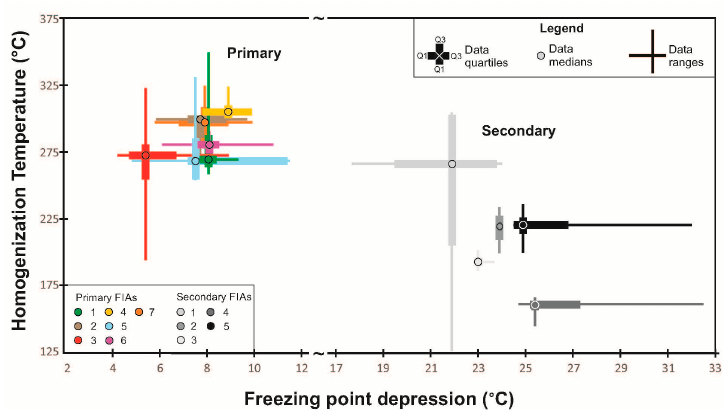
Figure 9. Two-dimensional box and whisker plot for two-phase liquid-rich fluid primary and secondary fluid inclusions from Poona emerald. Total homogenisation and ice melting temperatures are shown on the ordinate and abscissa axes respectively. The number of fluid inclusions measured for the primary assemblages are 4, 4, 5, 4, 5, 5, and 2 respectively. All secondary assemblages had four inclusions per assemblage. Data ranges less than the Q1 and Q3 conjugates are not shown.